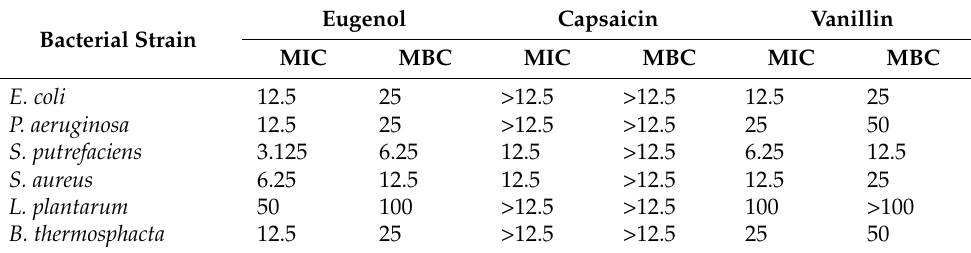
Table 3. Minimal inhibitory concentration (MIC) and minimal bactericidal concentration (MBC) in mM of eugenol, capsaicin, and vanillin on the strains tested. Bacterial